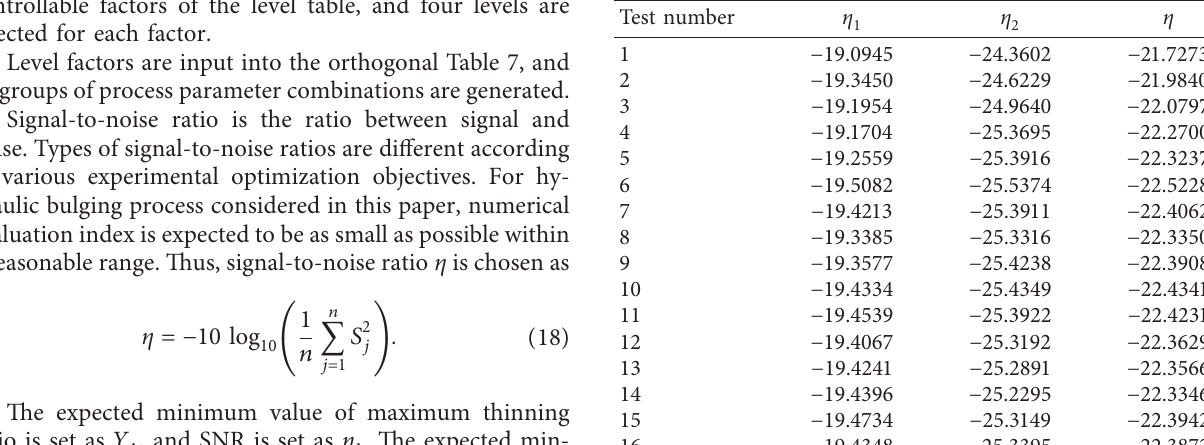
Table 8: SNR calculation results table.